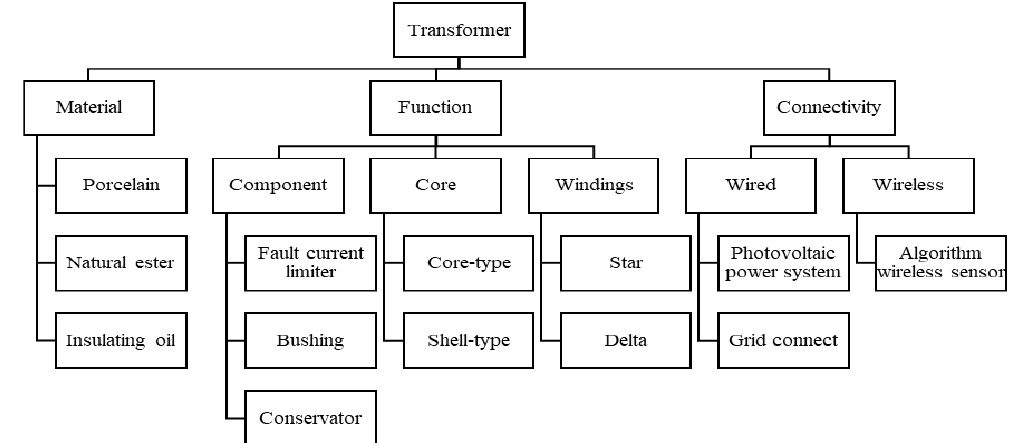
Figure 1. Ontology schema of power transformer design and manufacturing.